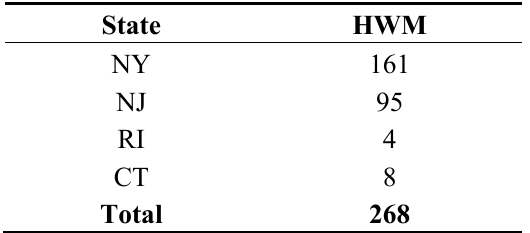
Table 10. Number of USGS High Water Marks (HWM) used to verify SLOSH-simulated maximum water levels for each state.